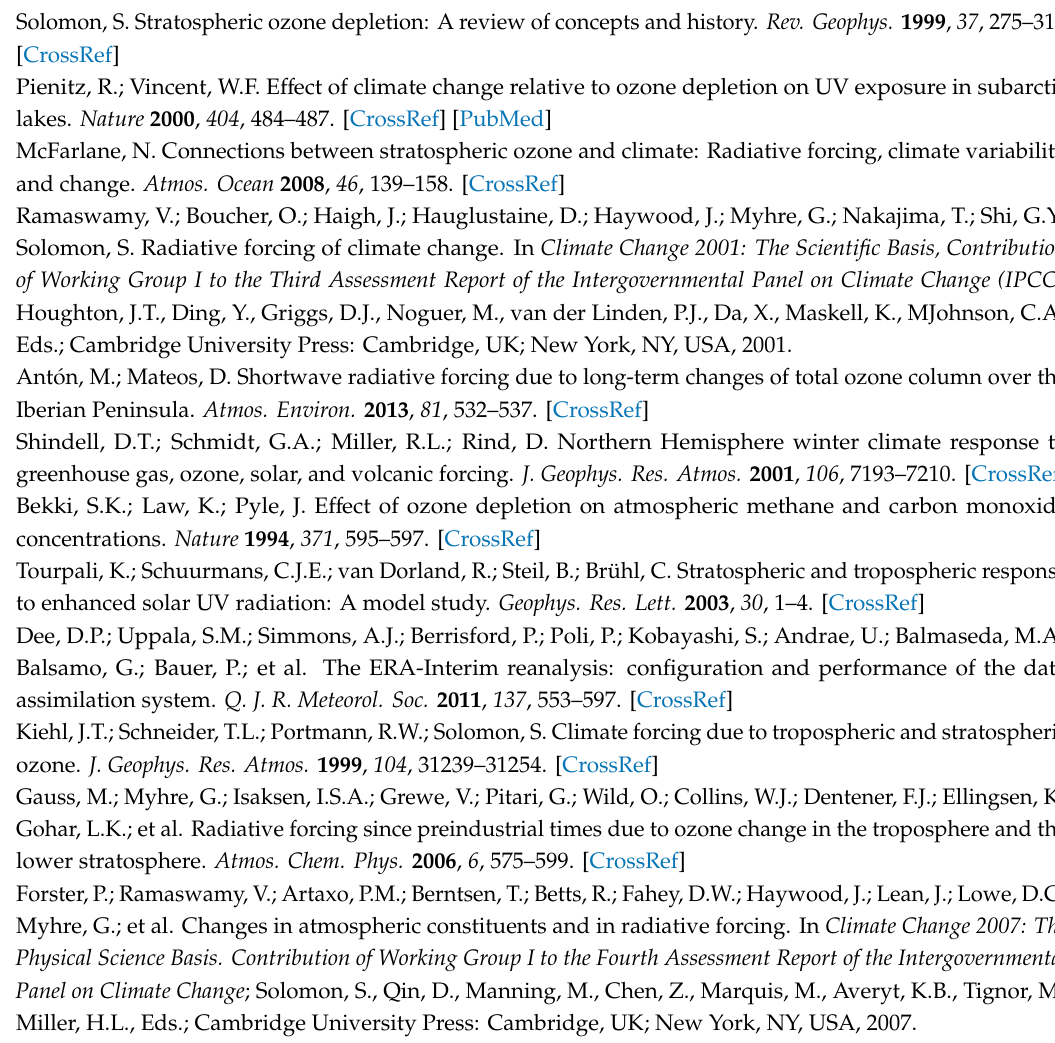
Figure S1: UV change (%): (a) ((UV net ) per2 − (UV net ) per1 ) / (UV net ) per1 ; (b) ((UV net ) per3 − (UV net ) per2 ) / (UV net ) per2 ; and (c) ((UV net ) per3 − UV net ) per1 ) / (UV net ) per1 . The periods are per1: 1979–1981 (background period), per2: 1994–1996 (middle period), and per3: 2012–2014 (present-day